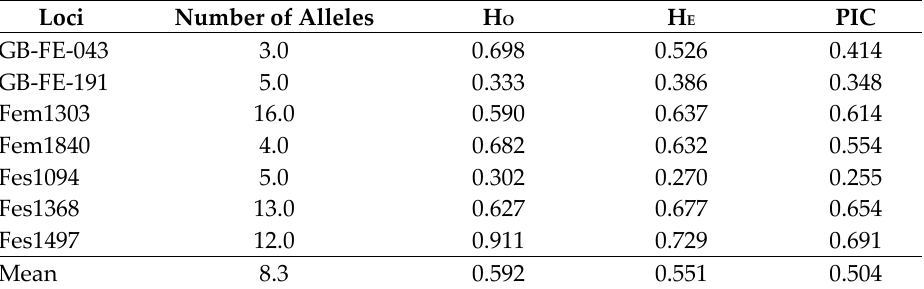
Table 1. Characterization of the 7 microsatellite loci used on 14 common buckwheat